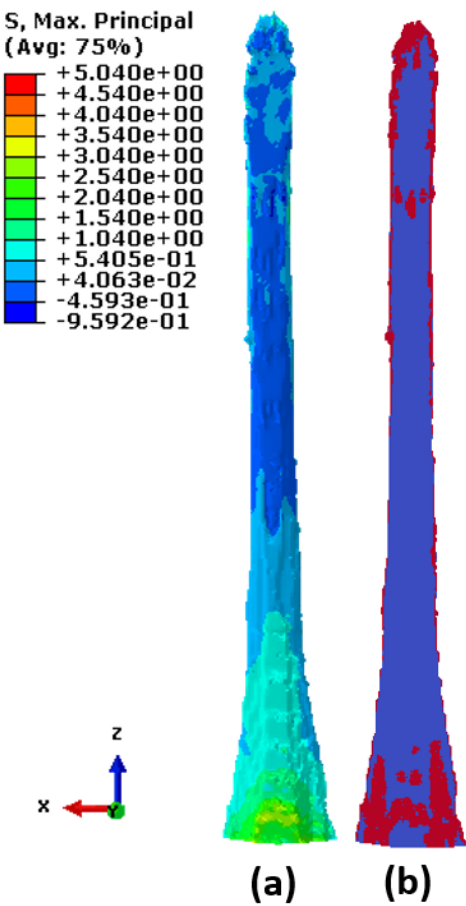
Figure 15. Soft cartilage of paddlefish rostrum. ( a ) Maximum principal stress obtained from finite element analysis. ( b ) Minimum cut obtained from mathematical analysis on top surface of rostrum’s soft cartilage. Nodes are colored by their respective locations on the source (red) or sink (blue) side of the minimum cut.